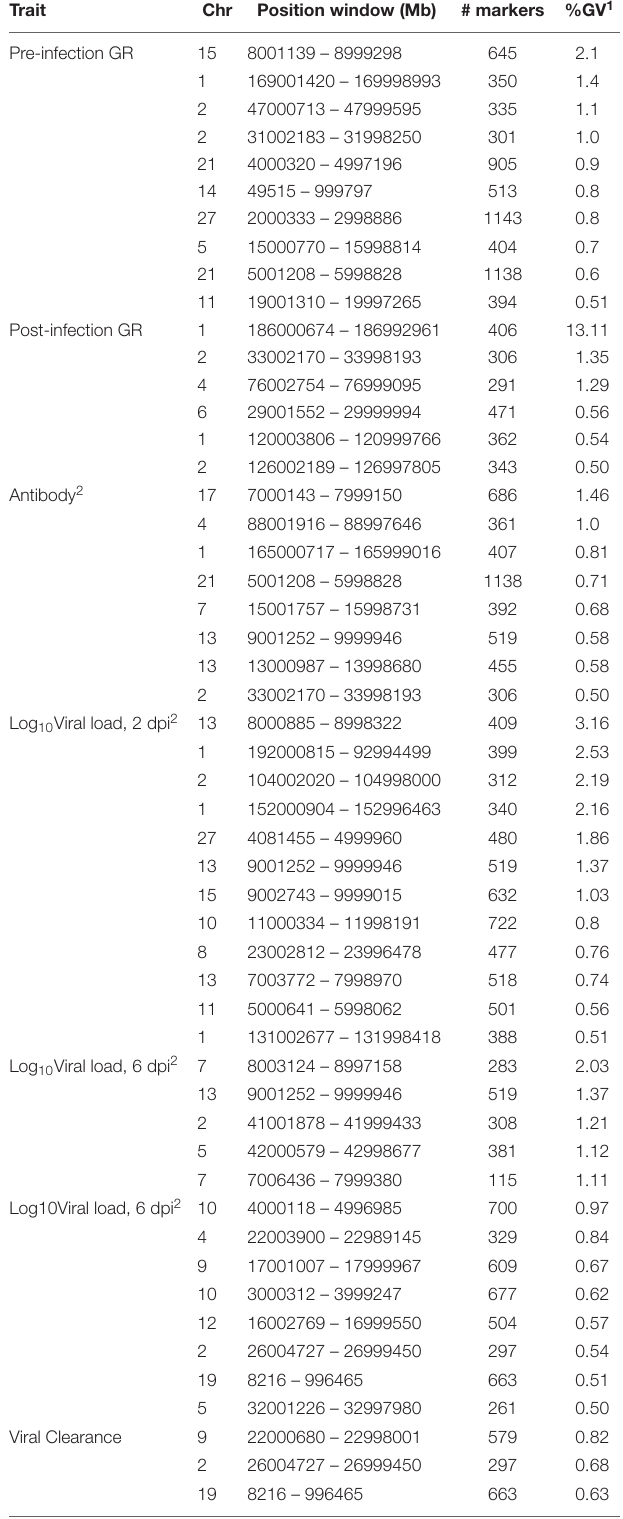
TABLE 4 | Percentage of genetic variance explained by 1-Mb genomic regions that are associated with NDV response traits in the Ghana local chicken ecotypes population based on the Bayes-B